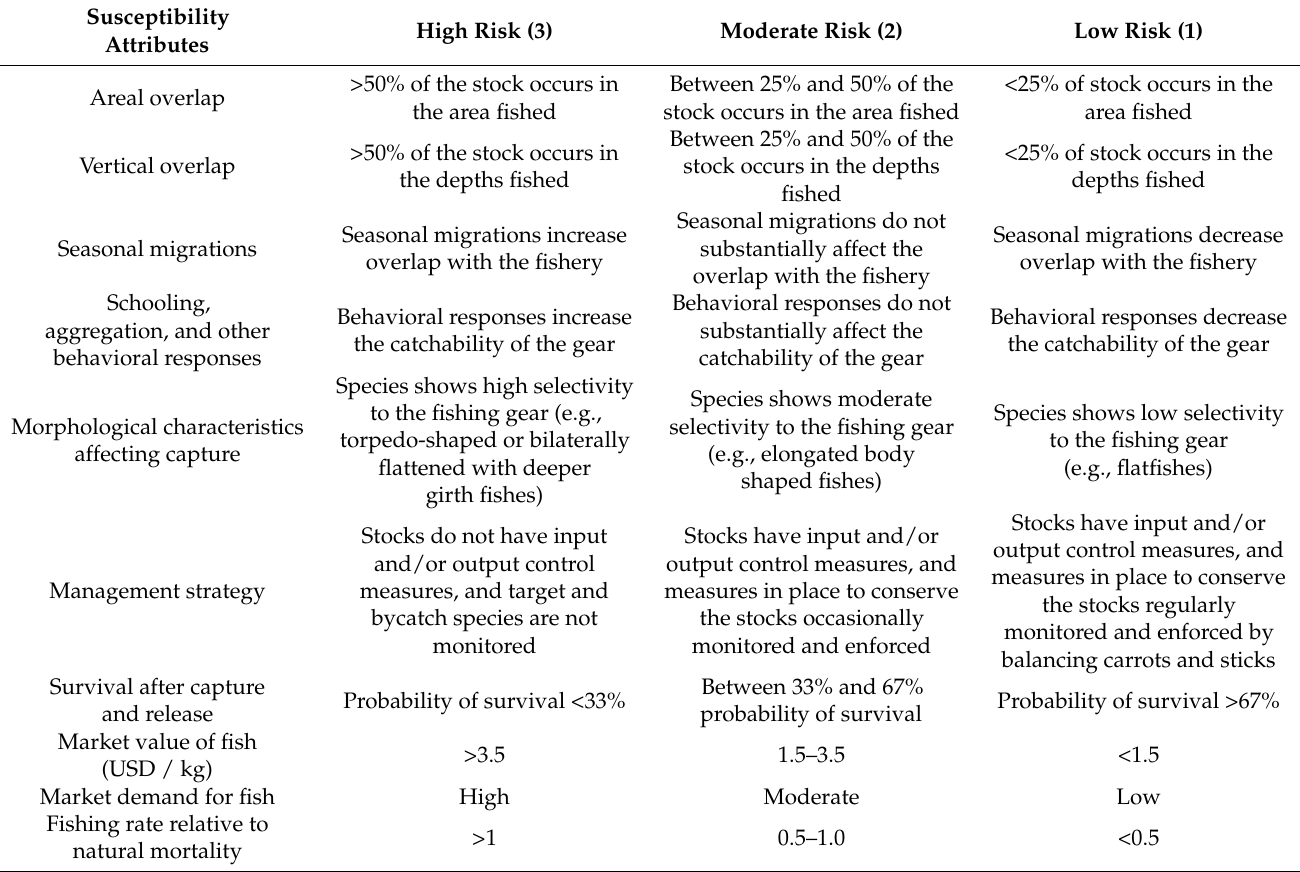
Table 3. A set of attributes and their scoring criteria were used to determine the susceptibility of the selected bycatch stocks from the Hilsa gillnet fishery in Bangladesh (adopted from Faruque and Matsuda,